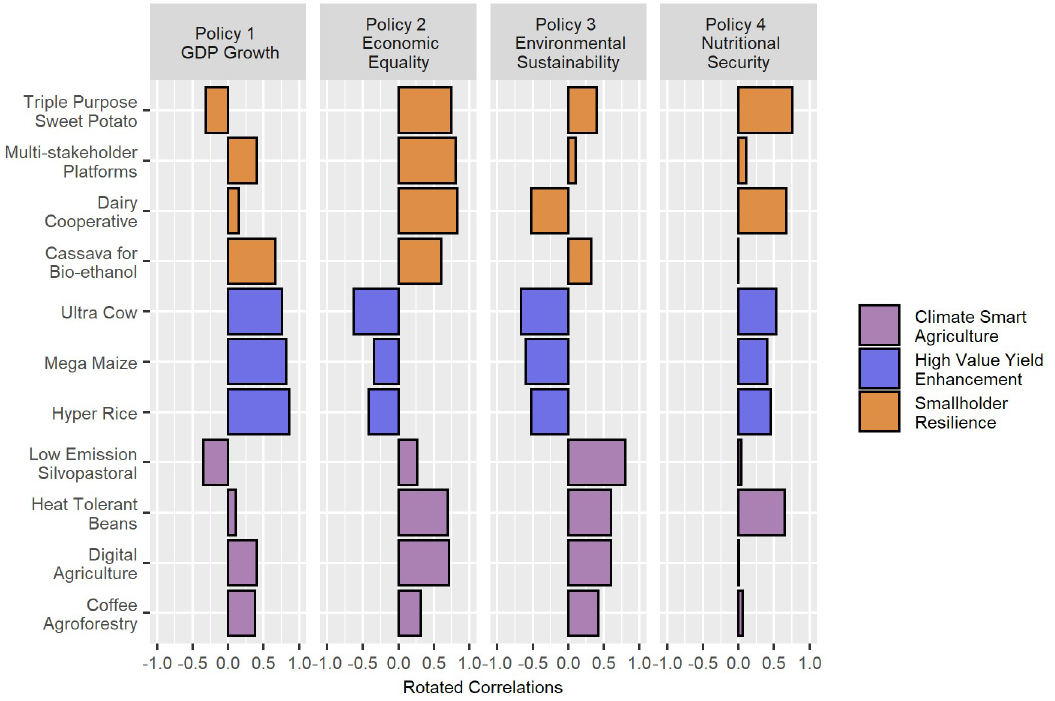
Fig 6. Hypothetical results of a survey eliciting policy-project correlations from experts and stakeholders.